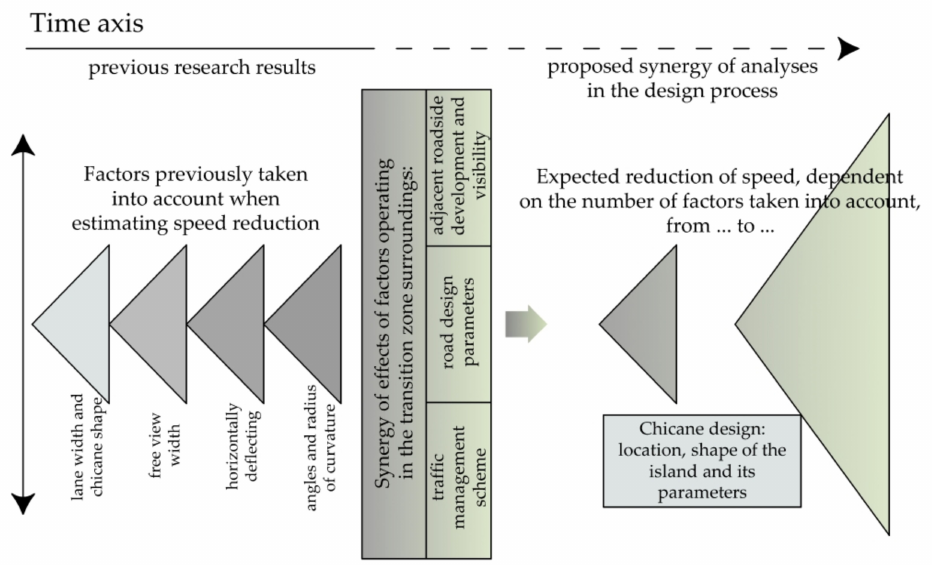
Figure 1. Visualisation of the state of knowledge on the effect of various factors on the reduction in speed based on the literature